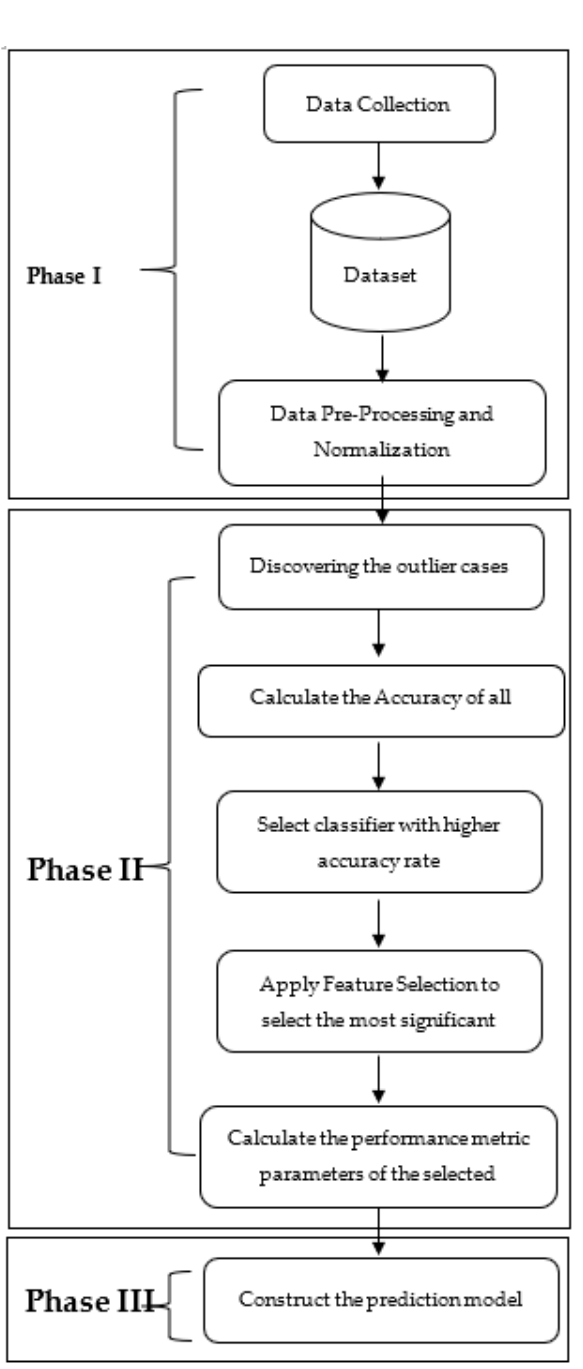
Figure 1. Block diagram of the proposed approach.